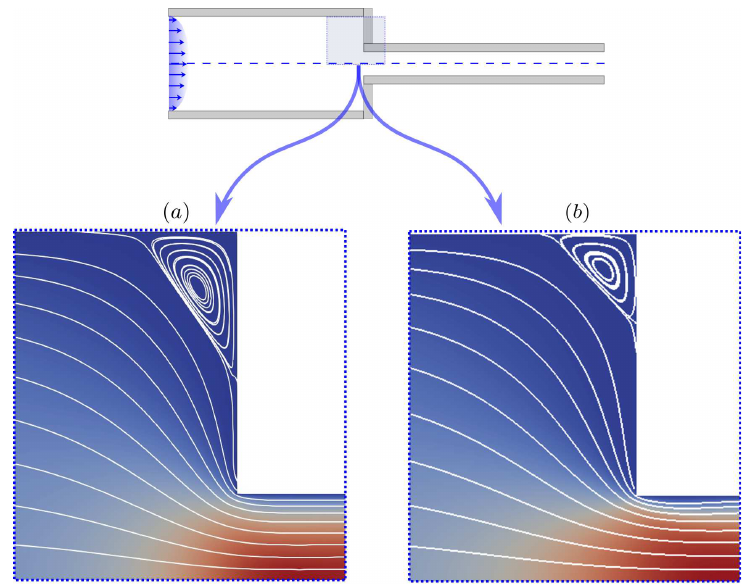
Figure 13. Streamlines of the contraction flow problem with De = 2.07. ( a ) OpenFOAM and ( b )